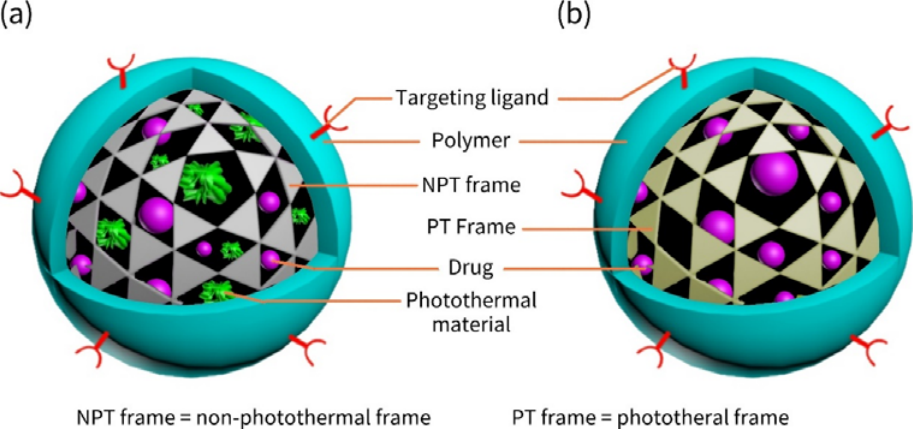
Figure 3 . Schematic illustration of frame ‐ coat structured nanocarriers. ( a ) Nanocarriers with a non ‐ photothermal frame and photothermal materials; ( b ) Nanocarriers with a photothermal frame. Table 2 . List of Frame ‐ Coat Structured Nanocarriers.